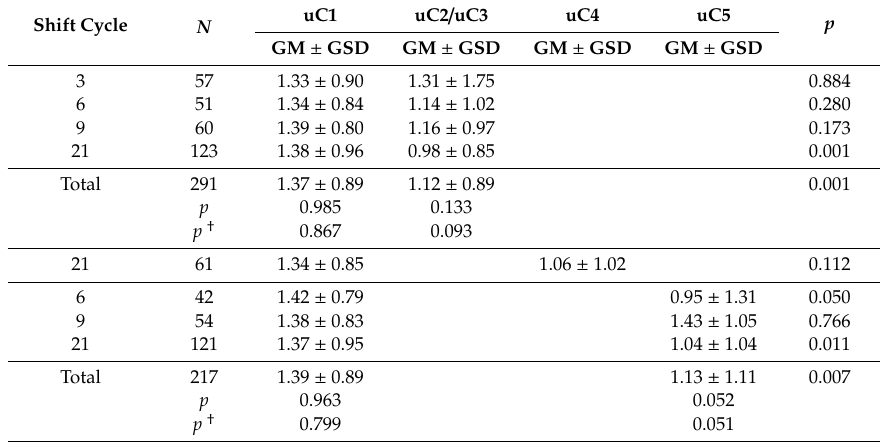
Table 4. The di ff erence of urinary cortisol level by working time and shift cycles (unit: µ g / dL). uC1 uC2 / uC3 uC4 Shift Cycle N